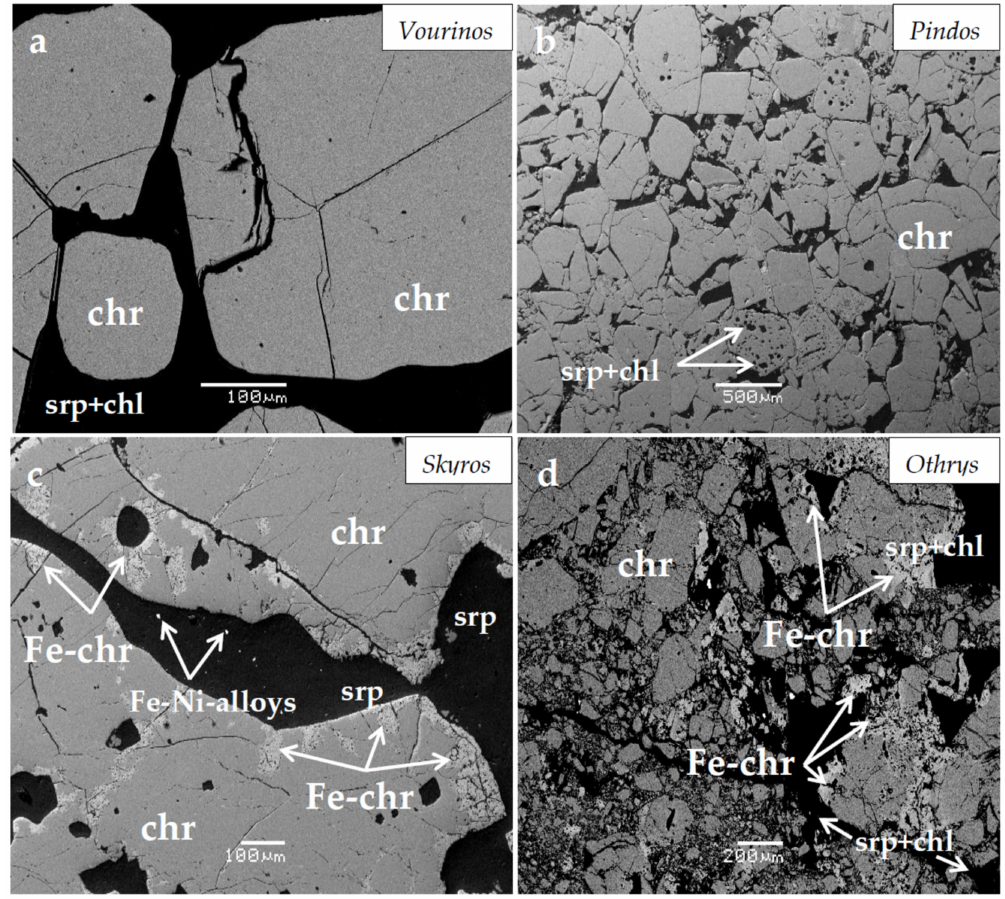
Figure 1. Representative back-scattered electron images of chromite ores from Greece, showing texture relationships between chromite and silicates, the presence of homogeneous chromite ( a ) and also abundant silicate inclusions (chlorite and serpentine) in the host chromite ( b ), porous texture and alteration to Fe-chromite ( c , d ). Abbreviations: chr = chromite; Fe-chr = iron-chromite; srp = serpentine; chl =